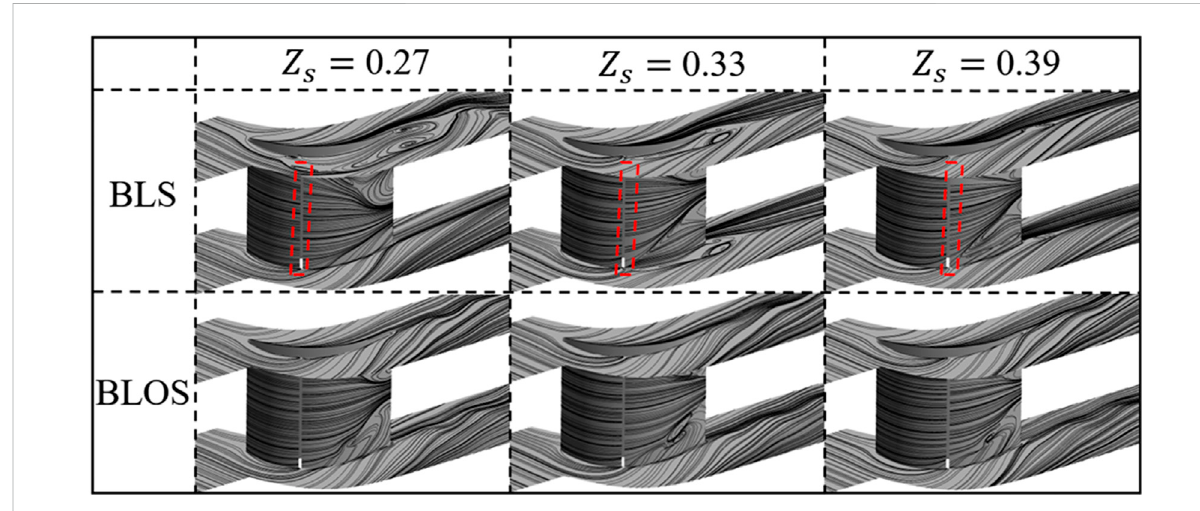
FIGURE 11 Instantaneous limiting streamlines by different suction locations in the control of BLOS and BLS.